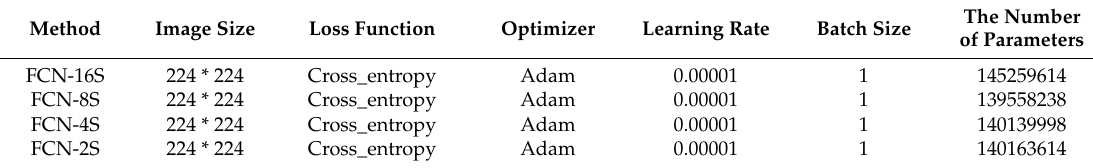
Table 3. Network parameter configuration and number of parameters.